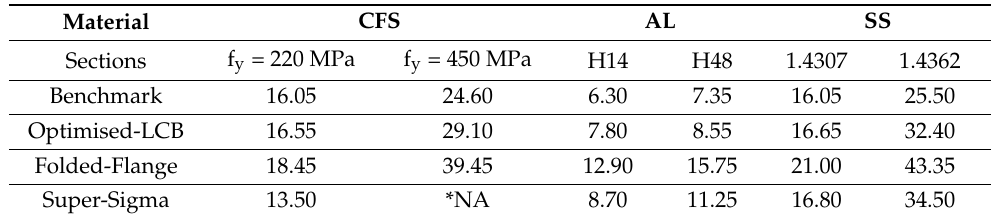
Table 6. Bending moment capacity for built-up sections.